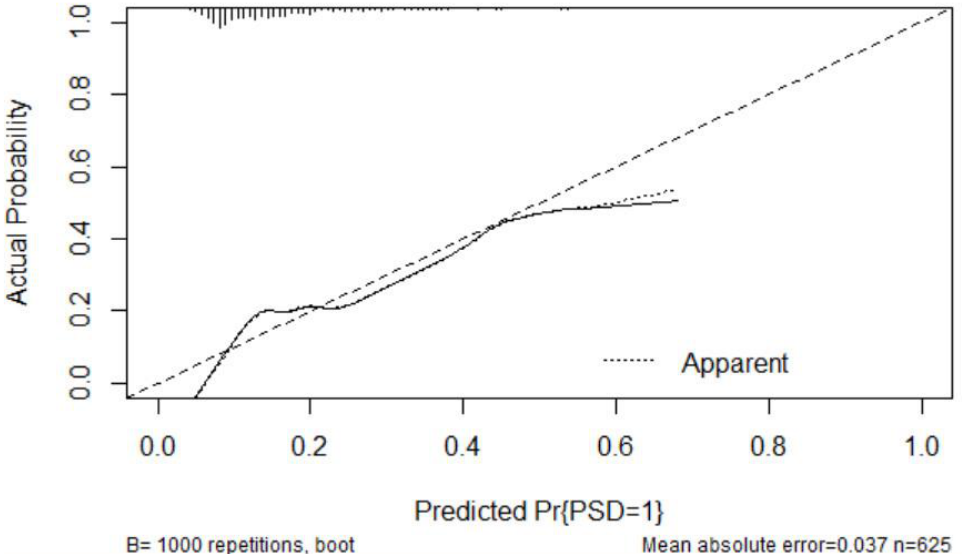
Figure 4. The calibration curve for predicting Post-stroke depression at discharge. NIHSS: National Institutes of Health Stroke Scale.